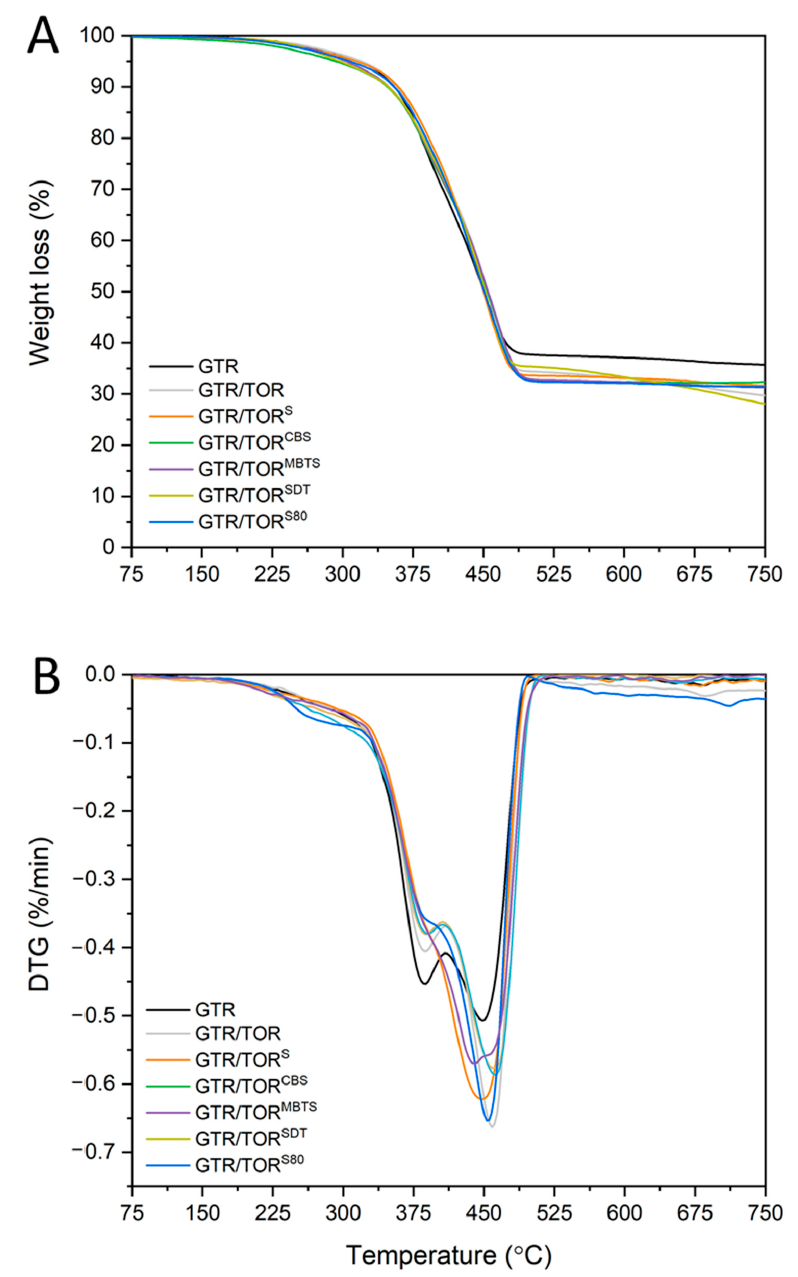
Figure 5. ( A ) TGA and ( B ) DTG curves of the studied samples.